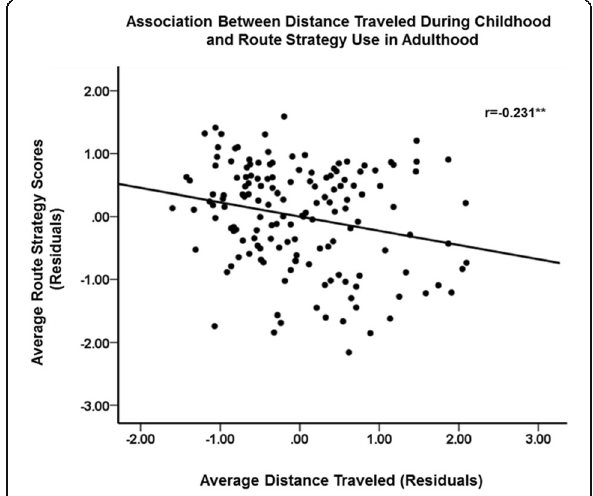
Fig. 6 Individual differences in the relationship between distance traveled and route strategy use, controlling for participant sex and trait anxiety. ** p < .01